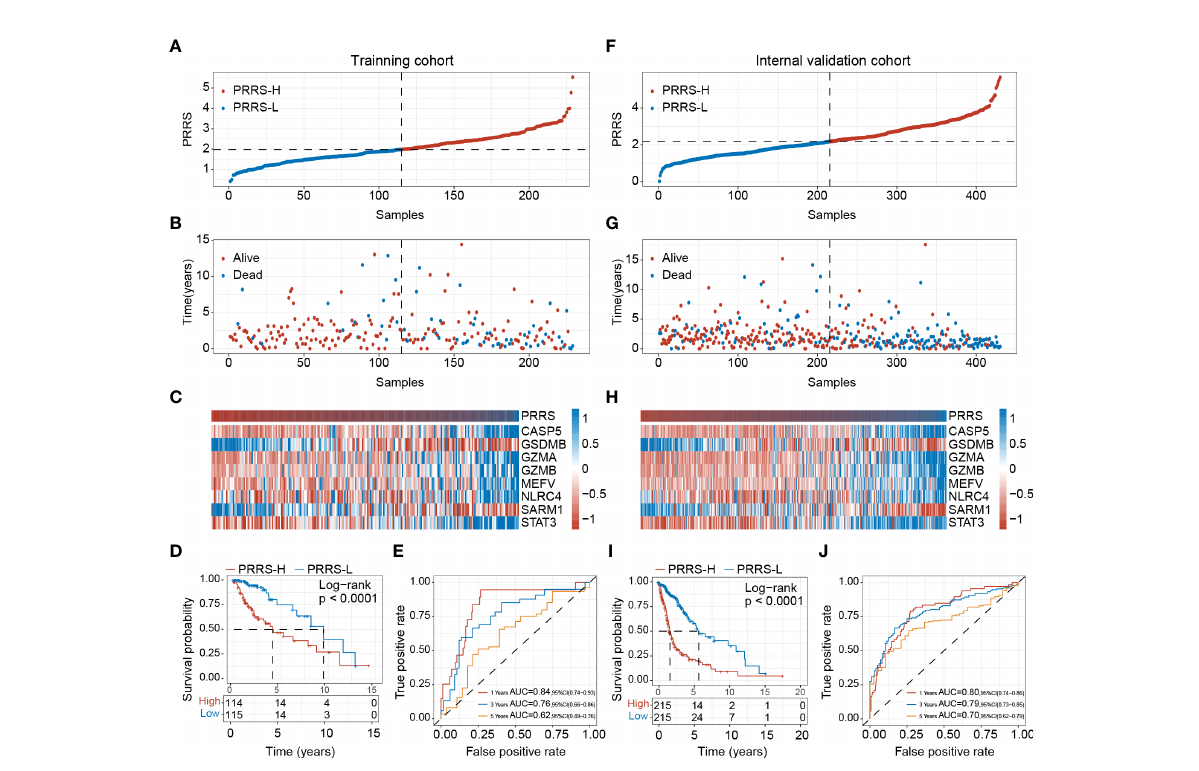
FIGURE 4 Establishment of pyroptosis-related risk score (PRRS). (A) PRRS value in the training cohort. (B) Survival status in the training cohort. (C) Expression pattern of the PRRS genes in the training cohort. (D) Survival analysis of different risk group for overall survival in the training cohort. (E) ROC curve analysis for 1-year, 3-year and 5-year overall survival in the training cohort. (F) PRRS value in the internal validation cohort. (G) Survival status in the internal validation cohort. (H) Expression pattern of the PRRS genes in the internal validation cohort. (I) Survival analysis of different risk group for overall survival in the internal validation cohort. (J) ROC curve analysis for 1-year, 3-year and 5-year overall survival in the internal validation